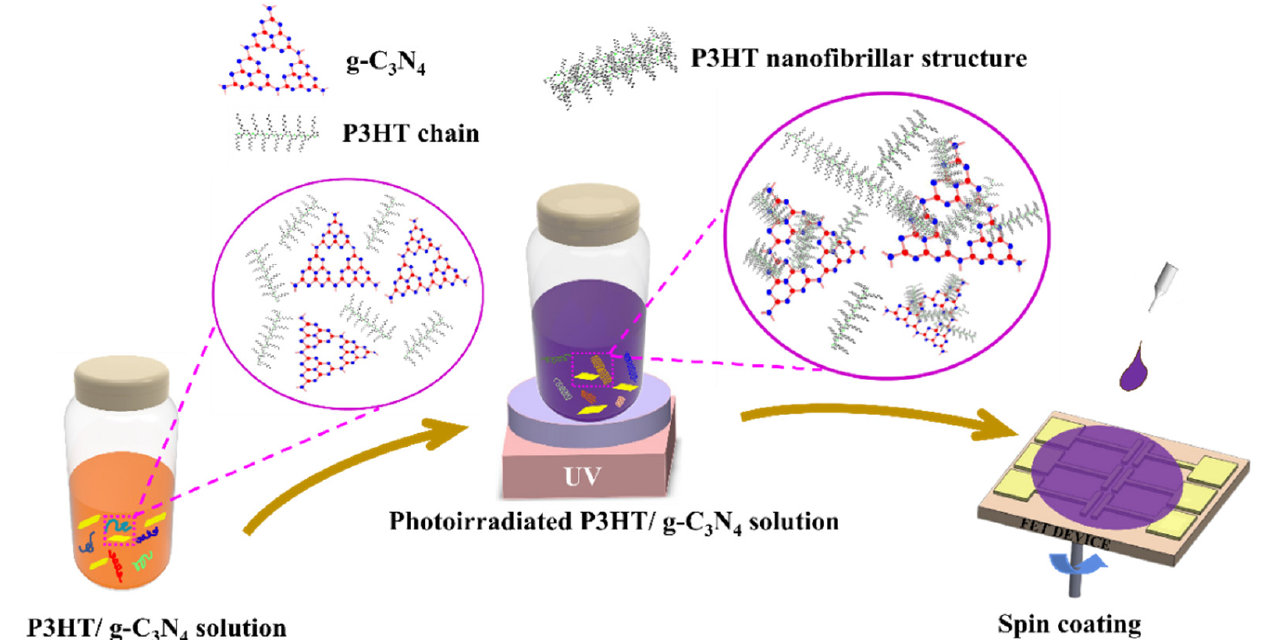
Figure 1. Schematic illustration of the preparation of P3HT/g-C 3 N 4 composite films by means of photoirradiation and the subsequent spin-coating of the composite solutions onto an FET device.